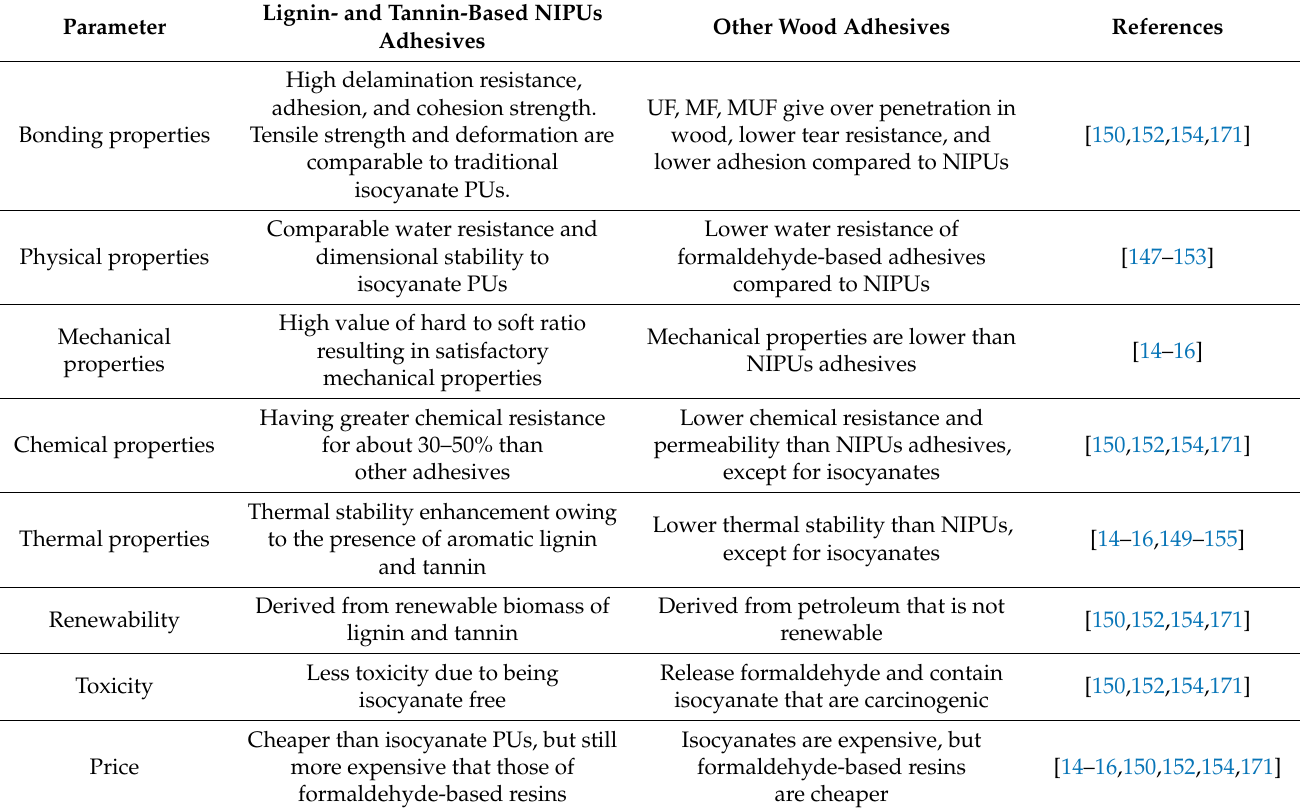
Table 2. Advantages of NIPUs compared to other